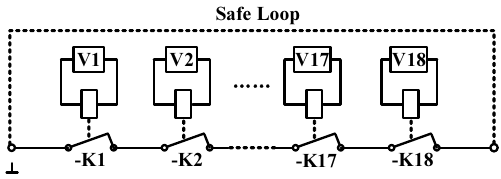
Figure 5. Schematic diagram of the safe